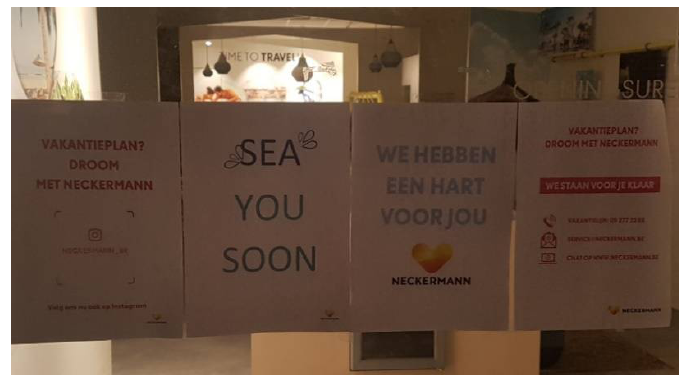
Figure 3. Sea you soon.